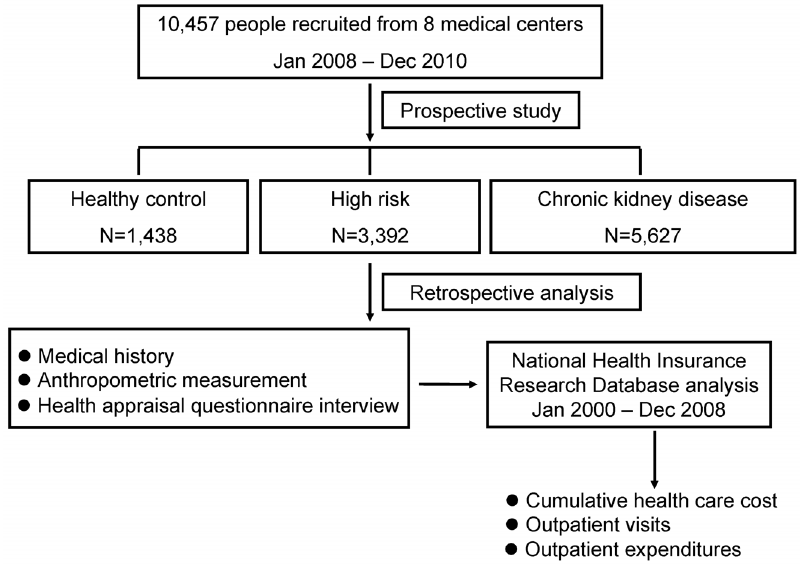
Figure 1. Flow chart of the selection process of the study participants.